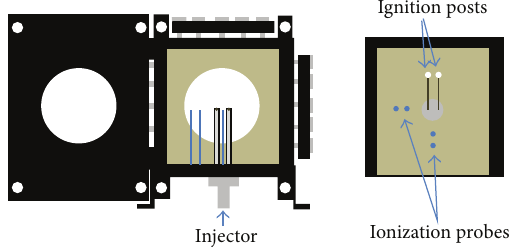
Figure 1: Schematic of the flame speed experimental setup.